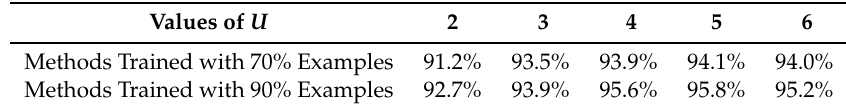
Table 11. A summary of the classification accuracy of the proposed boosting method with different values of parameter U